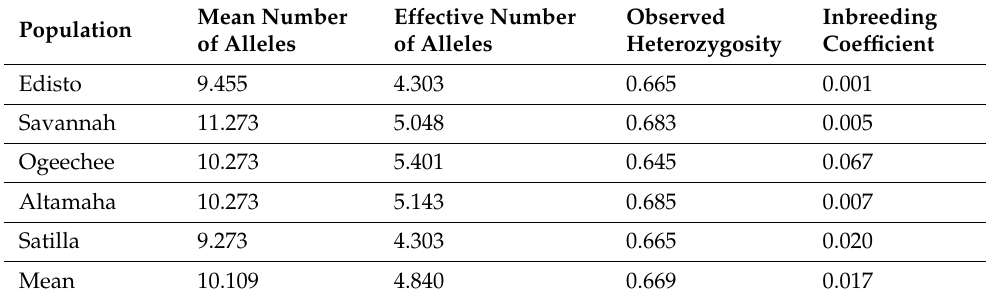
Table 3. Measures of genetic diversity based on microsatellite analysis at 11 loci within collections of Atlantic sturgeon juveniles from rivers in the South Atlantic